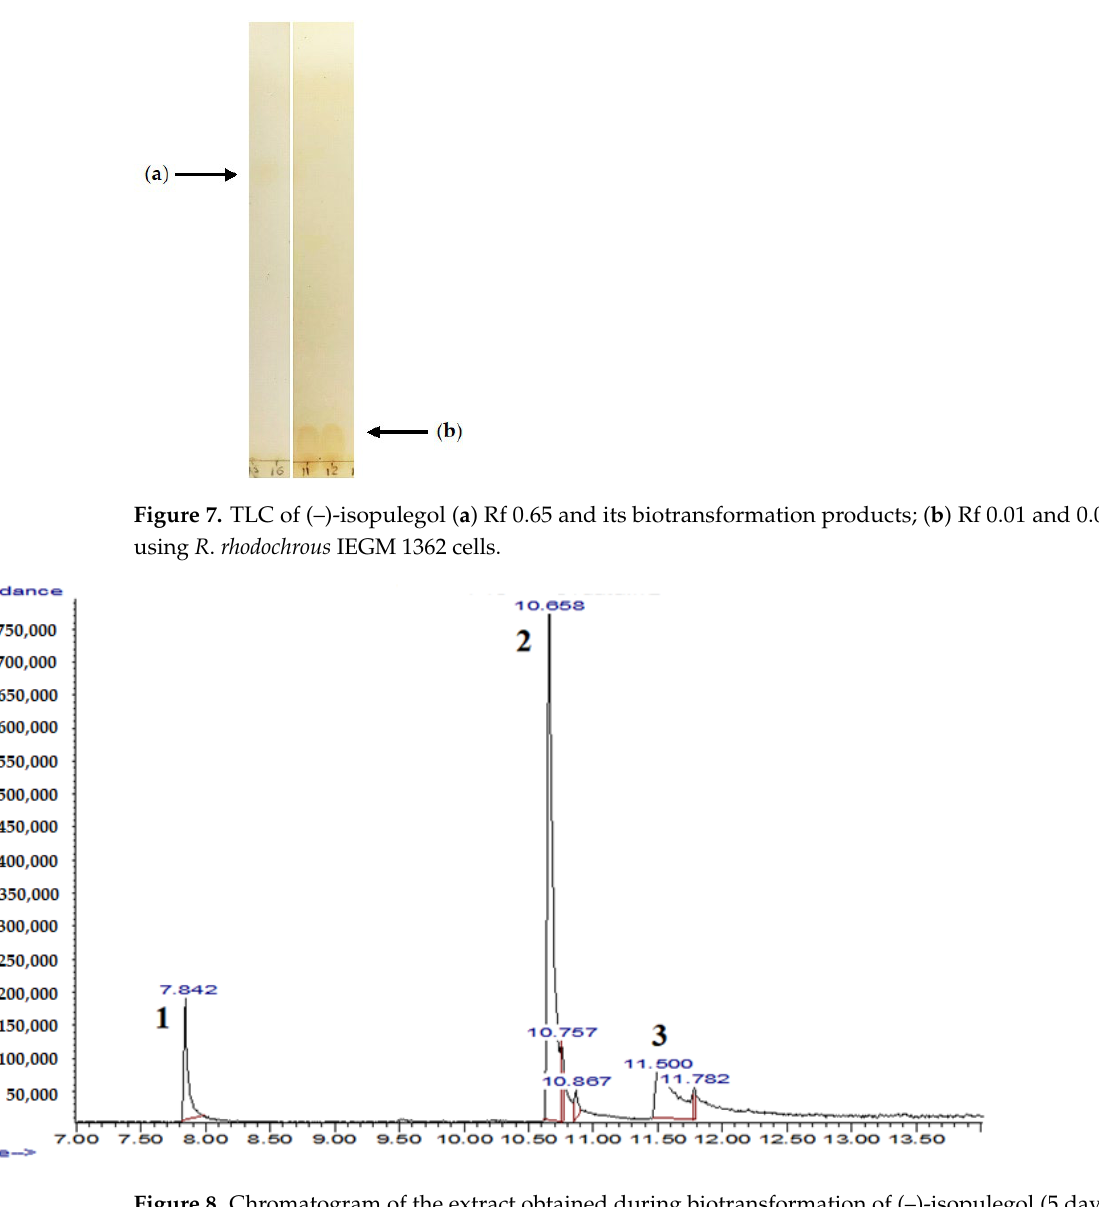
Table 1. Changes in ethyl acetate extract (%) composition during biotransformation of (‒) -isopulegol by R . rhodochrous IEGM 1362.